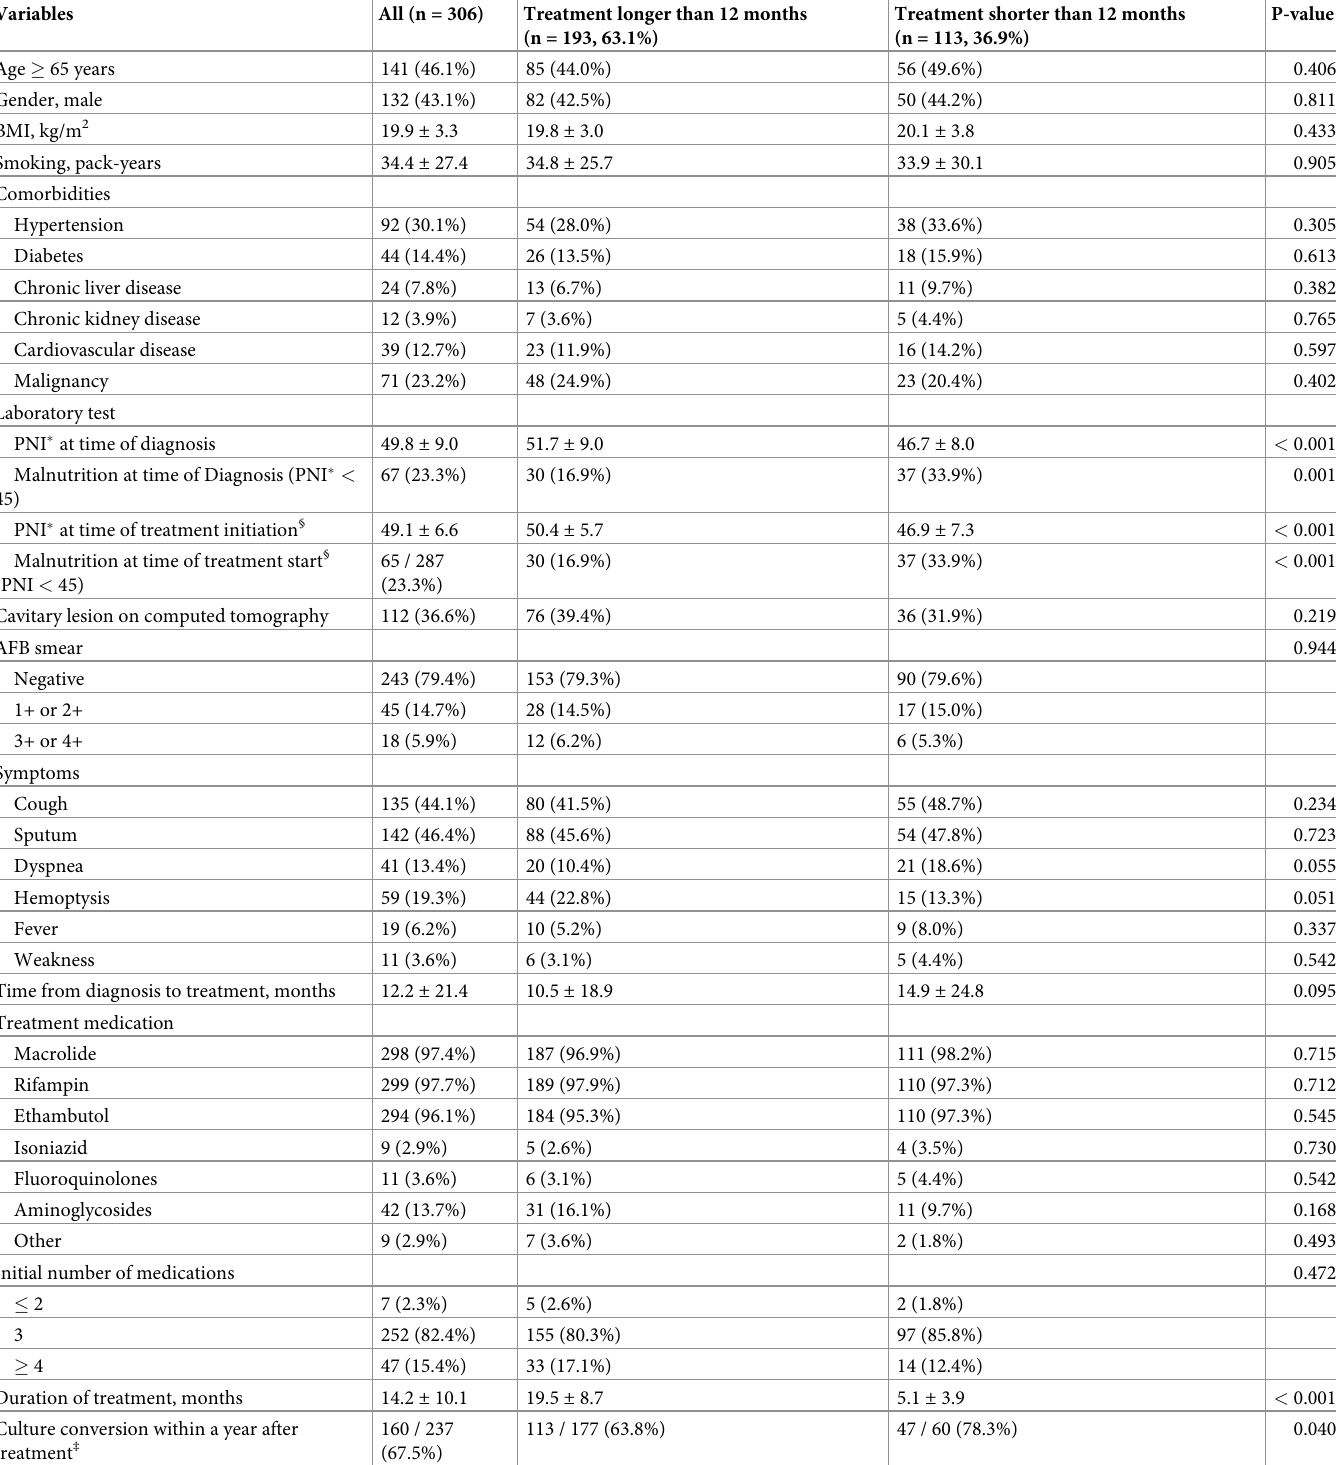
Table 2. Basic characteristics of Mycobacterium avium complex lung disease patients who started treatment according to treatment tolerance (12